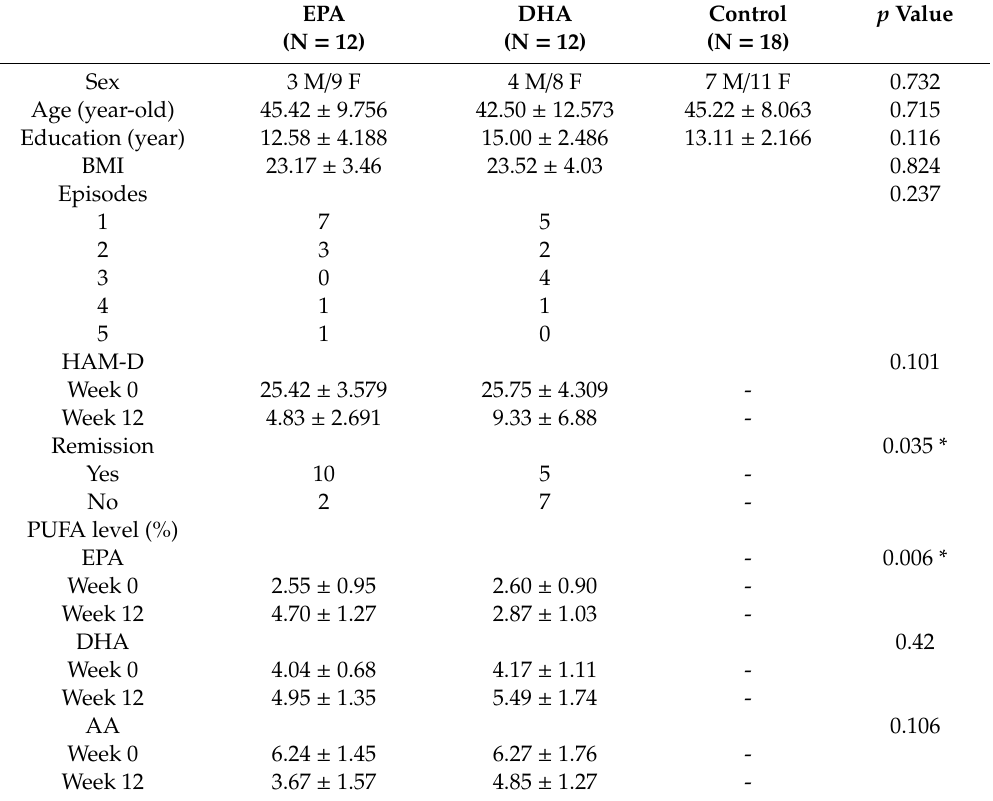
Table 1. Demographic data, clinical measurements, and concentration of blood polyunsaturated fatty